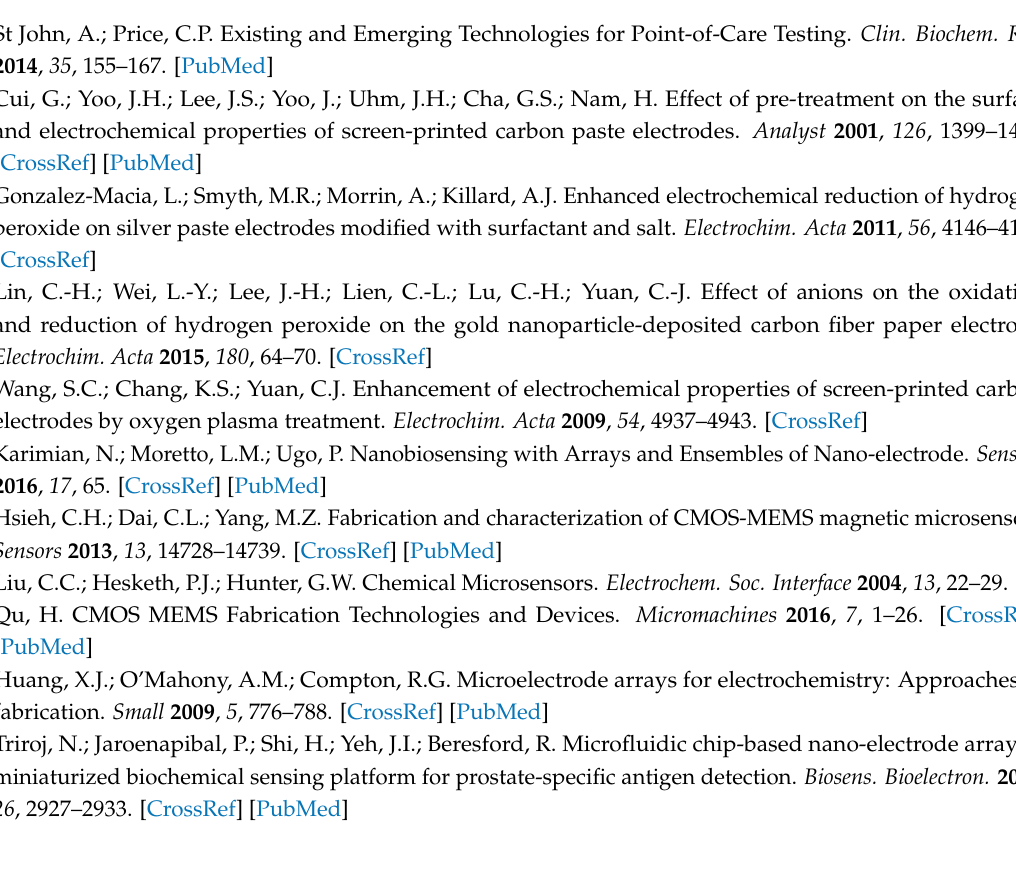
Figure S1: The CMOS sensing chip was fixed on a print circuitry board (PCB); Figure S2: Simulation of electric field distribution of microelectrode and nano-electrode array; Figure S3: The SEM imaging of the CMOS chip with